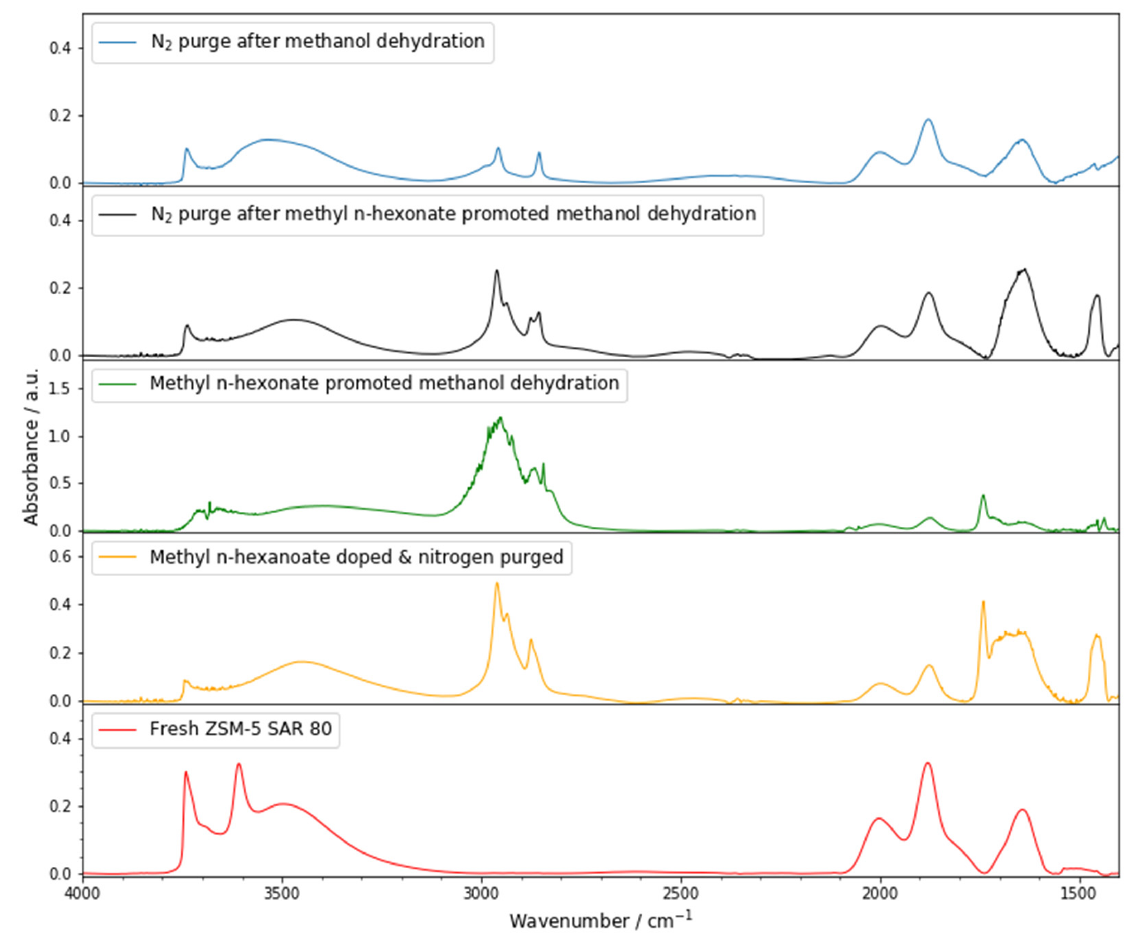
Figure 8. In-situ FT-IR of methanol dehydration to DME over methyl n -hexanoate-doped H-ZSM-5 SAR80 at 110 °C.